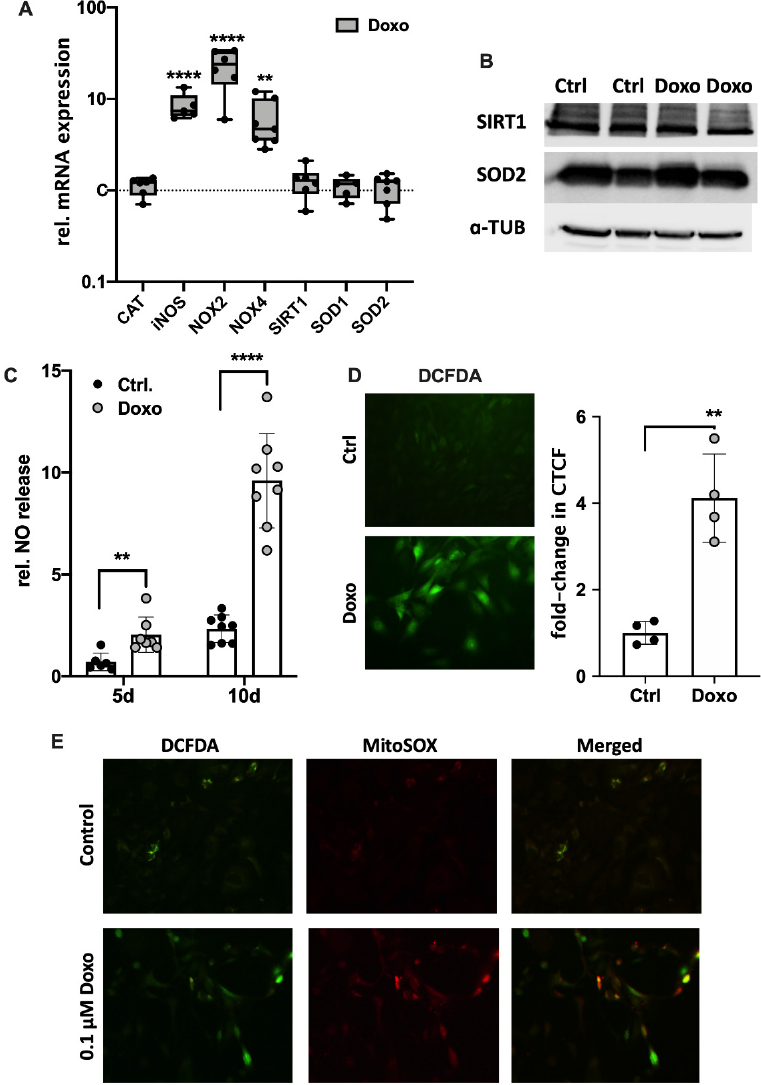
Figure 4. Effects of Doxo stimulation on oxidative stress markers in hAC. ( A ) Gene expression of iNOS, NOX2, and NOX4 as well as CAT, SIRT1, SOD1, and SOD2 after Doxo stimulation for 10 d. ( B ) Exemplary western blot analysis of SIRT1 and SOD2 after Doxo stimulation (n = 2); a-TUB = alpha tubulin. NO release into culture media of Doxo-treated hAC after 5 d and 10 d, respectively. ( D ) Representative images of DCFDA staining of unstimulated and Doxo-stimulated hAC after 7 d and corresponding quantification of the corrected total cell fluorescence (CTFC). ( E ) Exemplary co-staining of mitochondrial superoxide (MitoSOX; red) and cytoplasmic ROS (DCFDA; green) of unstimulated (Ctrlol) and Doxo-stimulated hAC after 7 d. Ctrl = unstimulated hAC. Data are presented as scatter plot with bars, mean with standard deviation; or box plots with median, whiskers min to max. Significant differences between groups are depicted as: **** p ≤ 0.0001; ** p ≤ 0.01. Statistical analysis: ( A ) One-way ANOVA, Sidak’s multiple comparison; ( C ) multiple t -test; ( D ) paired t-test. Ctrl = control (unstimulated cells), rel. = relative.